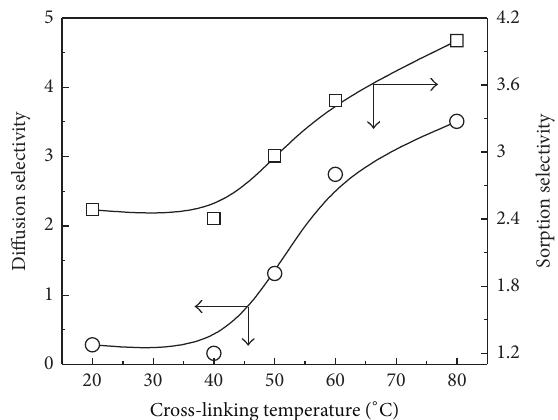
Figure 6: Effects of cross-linking temperature on the diffusion selectivity and sorption